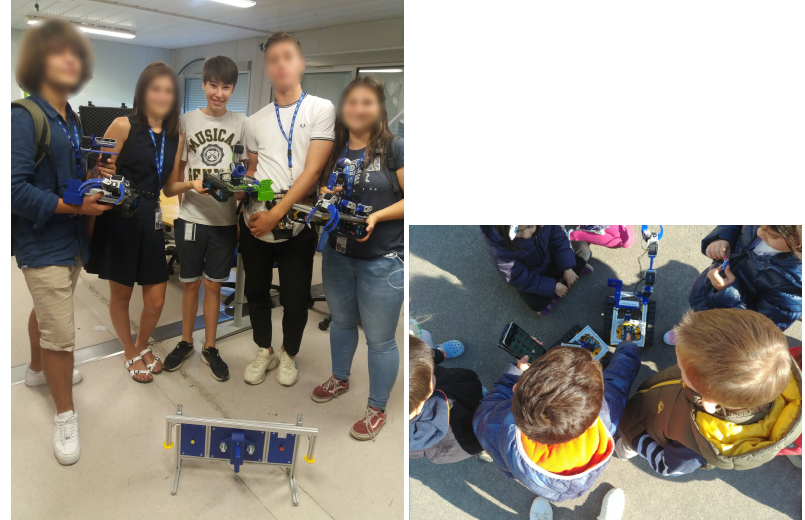
Figure 36. Final test with students: ( 1-left ) High-School Summer Stagers; ( 2-right ) Children at CERN’s kindergarten interacting with the educational robots developed on this